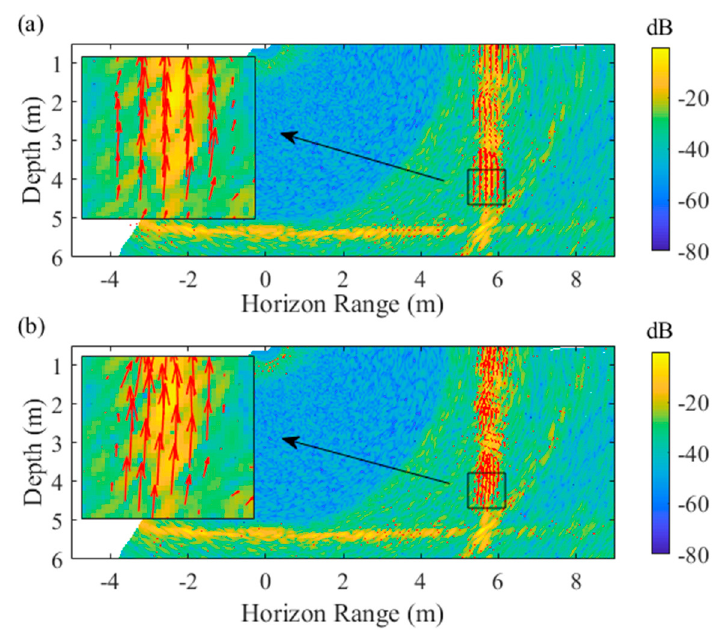
Figure 8. The joint display of the WCI and velocity field estimated by frame A ( a ) and frame B ( b ), respectively. The fixed nozzle aperture is =1.2 mm φ and the output intensity of pressure and the output flow rate are 0.5 MPa and 51 L/min,